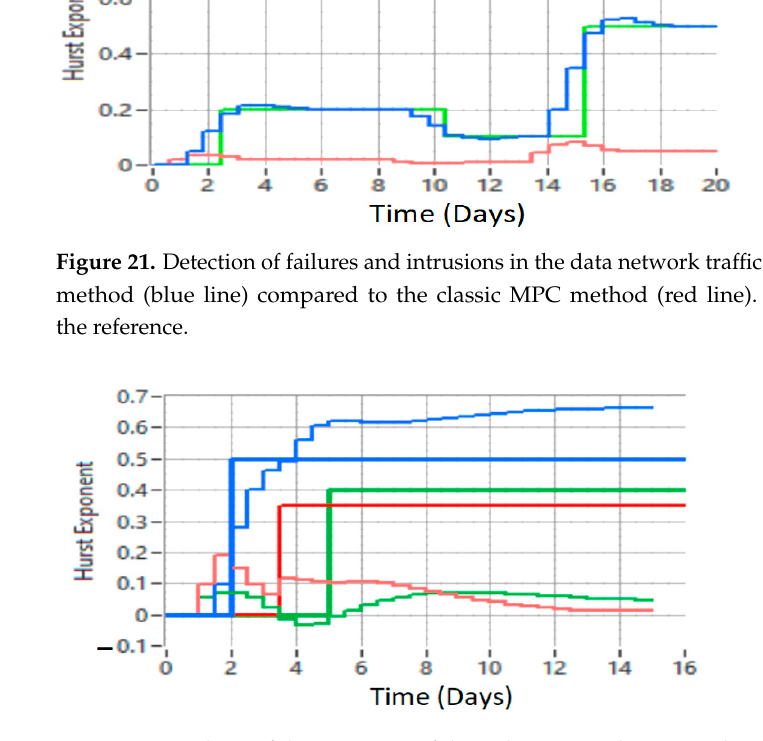
Figure 22. Analysis of the operation of three data networks: network 1 (blue line), network 2 (green line), and network 3 (red line).